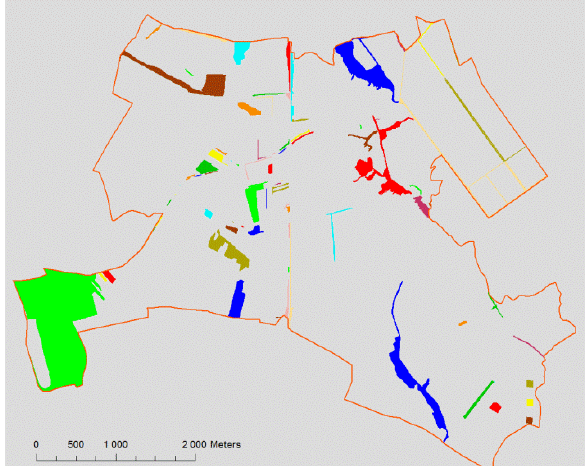
Figure 9. The results of the distance analysis of Label